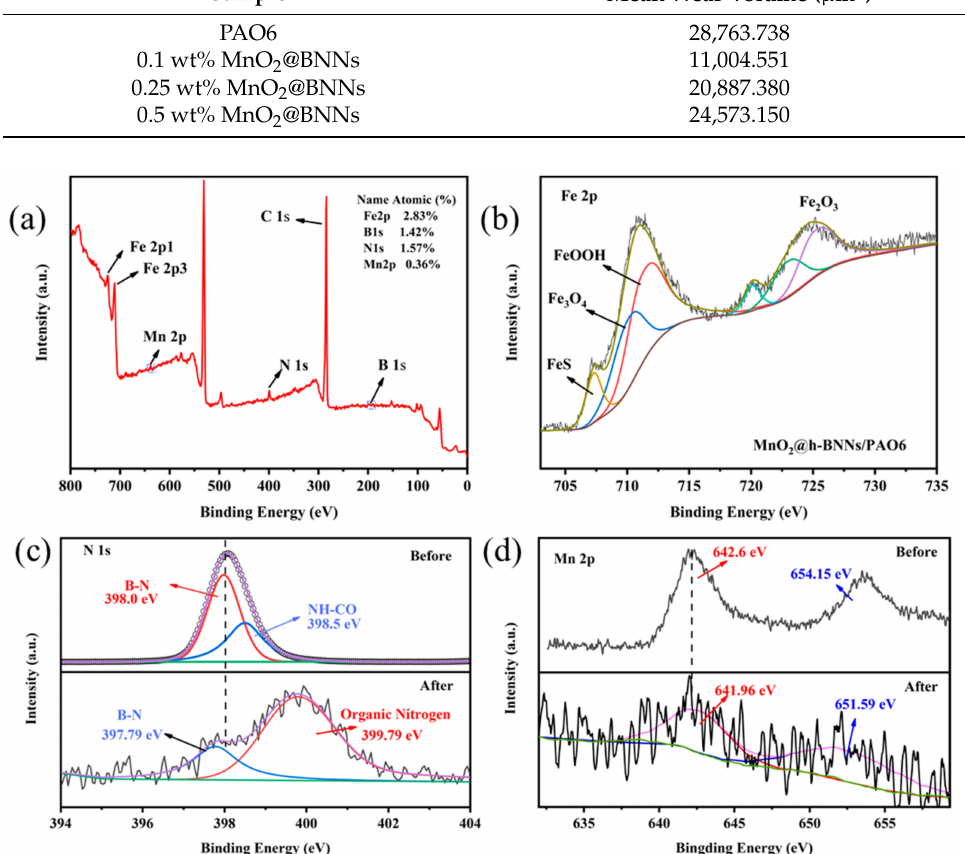
Figure 9. XPS spectrum: ( a ) full spectrum, ( b ) Fe 2p, ( c ) N 1s, and ( d ) Mn 2p on the surface of steel